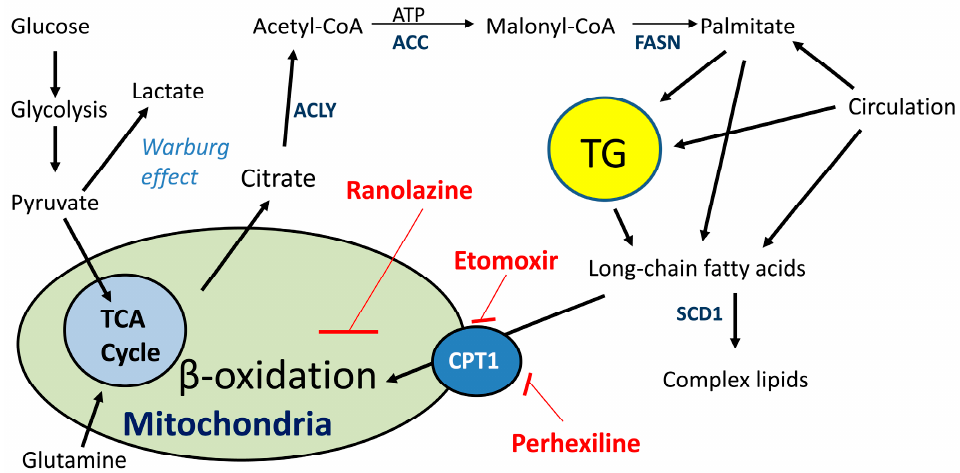
Figure 1. Warburg effect, lipid metabolism and site of action for metabolic drugs. Fatty acids are available from the circulation (diet), de novo synthesis from glucose and glutamine carbons or from hydrolysis of TG stores in lipid droplets. Fatty acids enter the mitochondria via the rate-limiting transporter CPT1. The metabolic drugs etomoxir and perhexiline inhibit entry of fatty acids into mitochondria by irreversibly inhibiting CPT1. Ranolazine works by decreasing β -oxidation in the mitochondrial matrix. The Warburg effect is active in the presence of oxygen, when lipids can be oxidized in the mitochondria. During hypoxia, the Warburg effect is enhanced as well as de novo lipogenesis, with a concomitant reduction in lipid oxidation, resulting in lipid accumulation inside the cells. ACC: acetyl-CoA carboxylase, SCD1: steroyl-CoA-desaturase, ACLY: ATP citrate lyase, CPT1: carnitine palmitoyl-transferase, TG: triglyceride, FASN: fatty acid synthase, TCA: tricarboxylic acid.